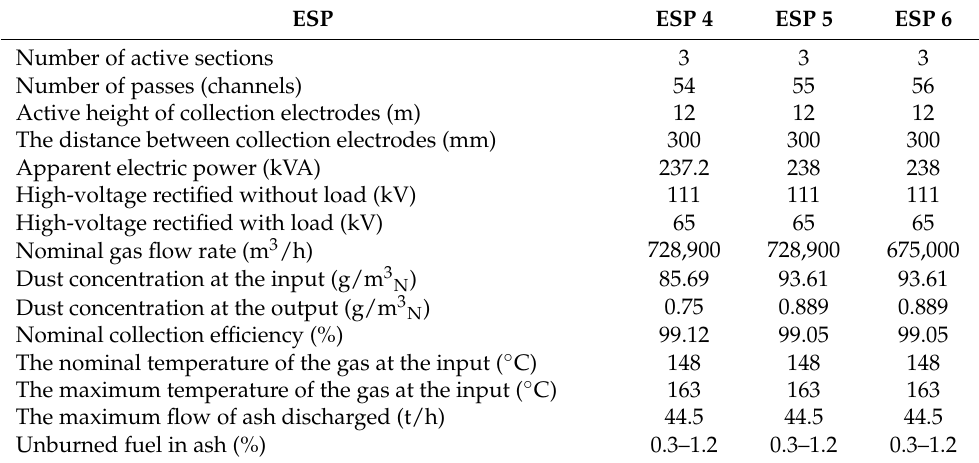
Table 1. Technological and electrical features of ESPs with three sections [29–32]. ESP Number of active sections Number of passes (channels) Active height of collection electrodes (m) The distance between collection electrodes